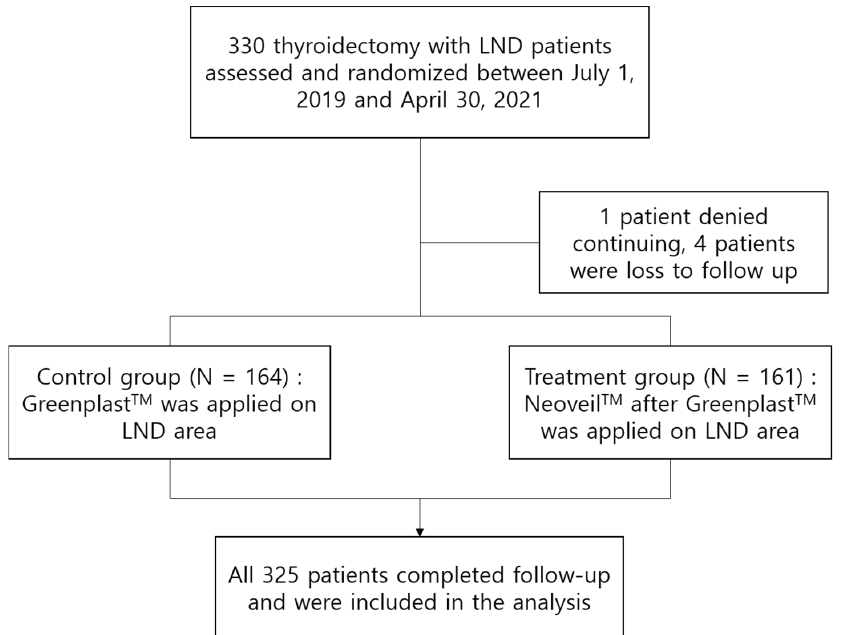
Figure 2. Flow chart for study enrollment.